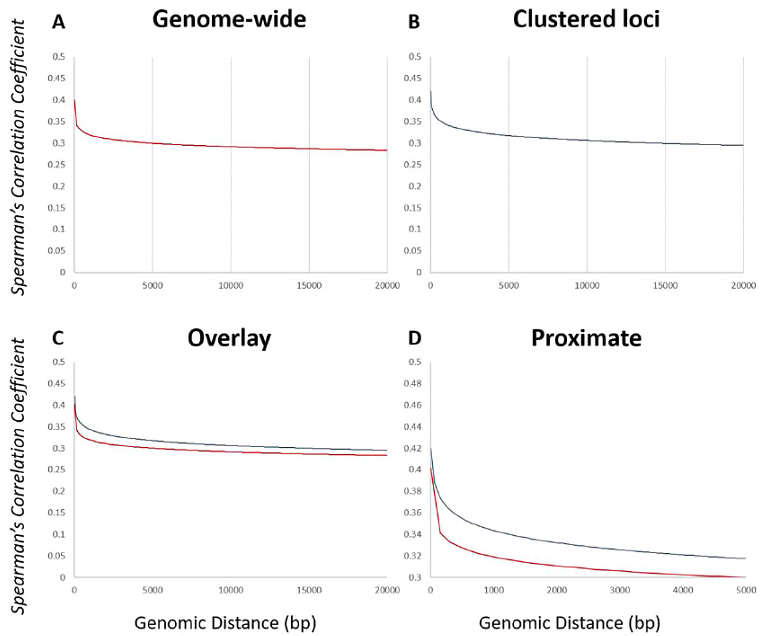
Figure 3. Functionally related genes congregate to transcriptionally permissive genomic loci. The Spearman’s correlation coefficient was calculated as a function of genomic distance globally ( A ) and for the functionally clustered gene set ( B ) and the logarithmic decay of best fit was determined for the datasets. These functions were overlaid ( C , D ) for clarity of comparison. The red trend line represents the genome-wide dataset and the blue represents the clustered